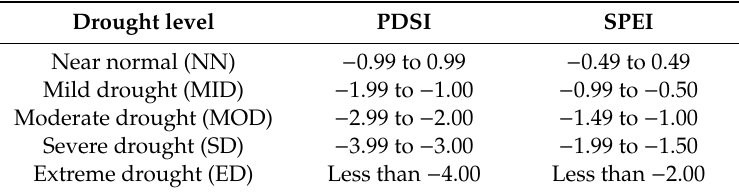
Table 1. Drought level classification according to PDSI and